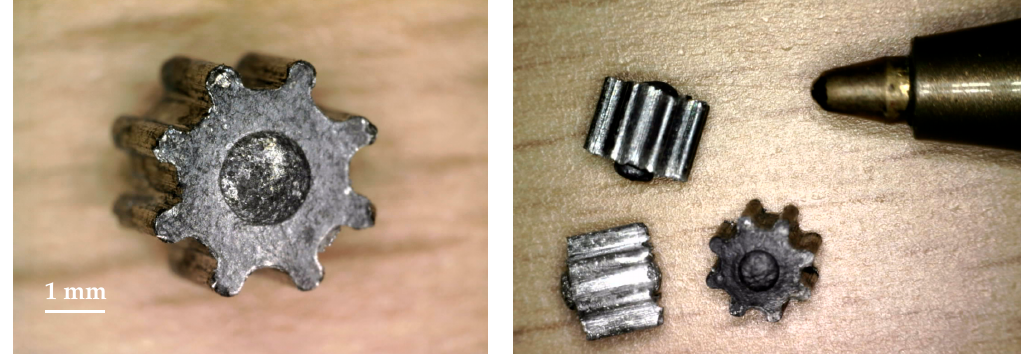
Figure 6. Examples of sintered samples using different process parameters. A pen tip was used to give an idea of the real size of the micro-gears.